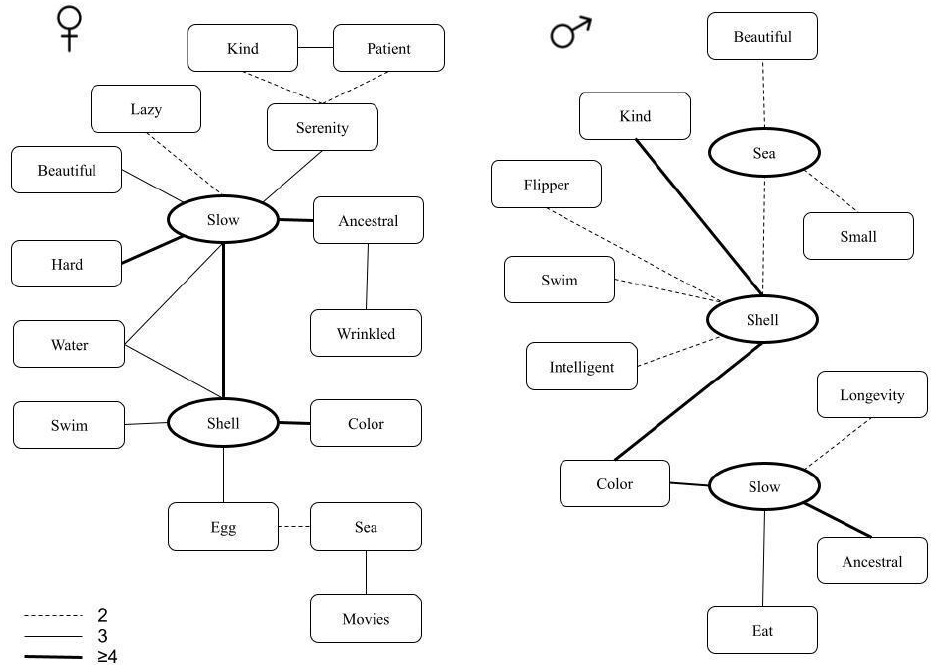
Figure 7. Tree with the elements of the social representations of turtles (female vs. male participants).